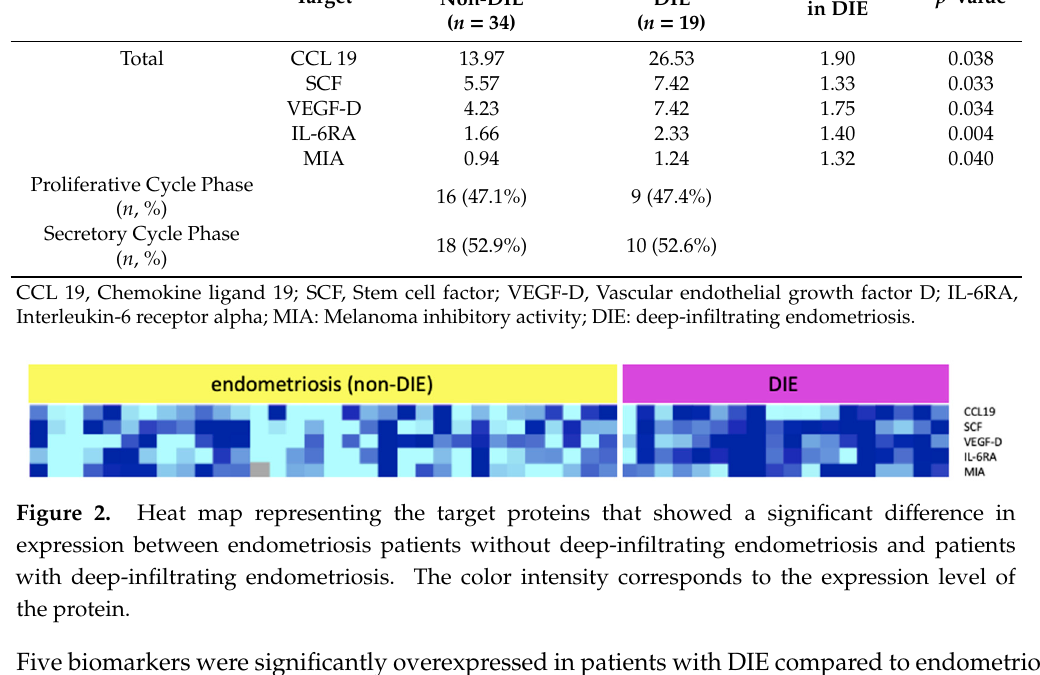
Table 4. Summary of the characteristics of factors that are significantly enriched or depleted in endometriosis patients compared to controls. IR: immune response, AG: angiogenesis, CP: cell proliferation, CA: cell adhesion, AA: anti-apoptosis. Target